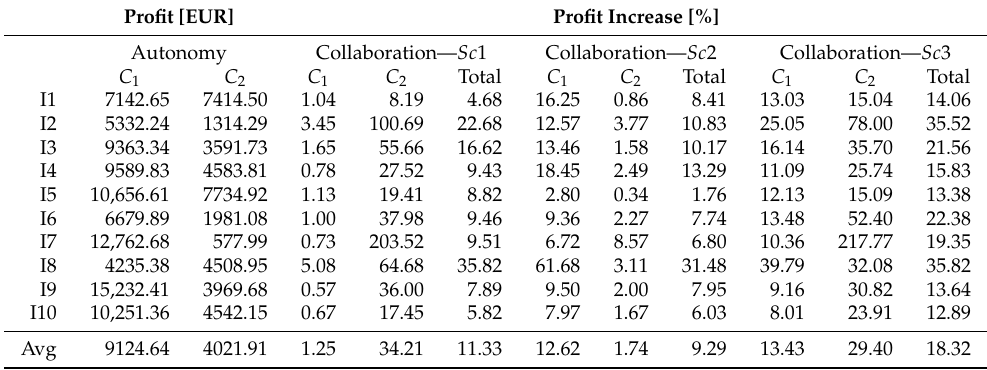
Table 15. Profit comparison mous and collaborative distribution under the three different scenarios.